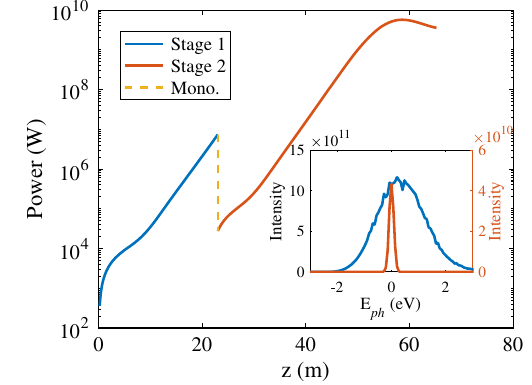
FIG. 1. Average FEL power along the undulator in the simulations of the self-seeding mode. A monochromator is applied between the two stages. The inserted figure shows the spectra before (blue) and after (red) the monochromator. The power and spectra are both averaged over 500 shots.